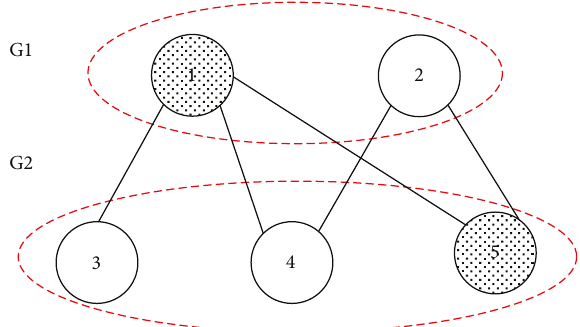
Figure 1: The undirected bipartite